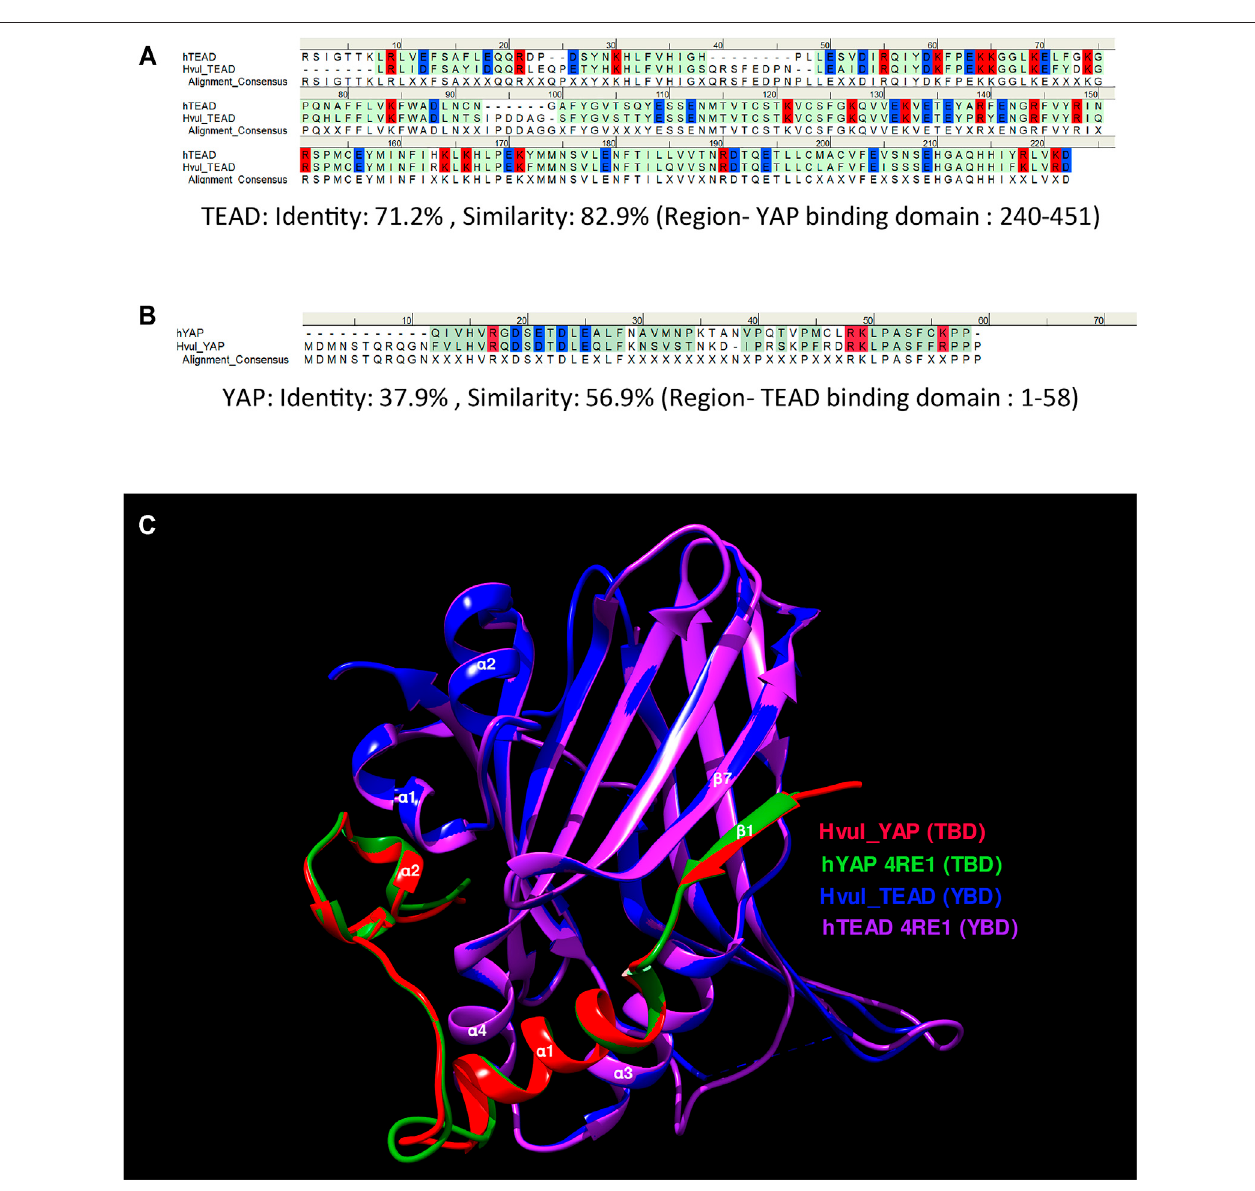
FIGURE 2 | YAP-TEAD interaction domain is structurally conserved in Hydra . (A) Sequence alignment of human and Hydra TEAD YAP-binding domains (YBD) showing 71.2% sequence identity. (B) Sequence alignment of human and Hydra YAP TEAD-binding domains (TBD) showing 37.9% sequence identity. The alignment consensus shows conserved amino acid residues at a given position. If the there is no conservation, the position is labelled as X. Colour code: amino acid residues with positive charge-red, negative charge-blue and neutral-green. (C) Structural superposition of predicted Hvul _TEAD YBD and Hvul _YAP TBD with YBD and TBD complex in Human (PDB:4RE1) showing highly conserved β -strands and α -helices structural placement. Important α -helices and β -strands are indicated with their number identi fi cation which are involved in the interaction of YBD and TBD. Colour code: Red- Hvul _YAP TBD, Blue- HVUL _TEAD YBD, Green-human YAP TBD (PDB ID-4RE1),Purple-humanTEADYBD(PDBID-4RE1).D)InteractionofYBD(greencolor)withtheTBD(purplecolor)in Hydra modelledusing4RE1structureshowinghow the globularYBD (depicted in surfacefeatures) isbound byTBD (depicted asribbon) through interactions at three differentregions-region1, region 2,and region3. The amino acid side chains from TBD are represented as sticks for understanding their role in the